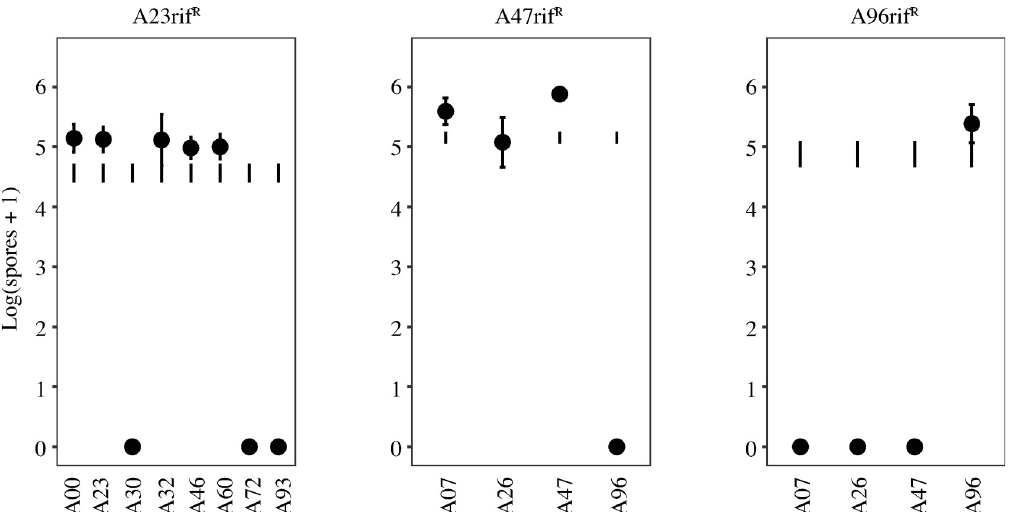
Fig 8. Antagonism patterns of focal minority strains in mixed groups during starvation-induced development. Actual spore production by marked natural isolates mixed in the minority at a 1:99 ratio with unmarked isolates (indicated on the x axis) prior to starvation-induced development is represented by closed circles. Expected spore production ranges of the minority strains based on pure-culture assays are depicted by error bars with no circles. Error bars represent 95% confidence intervals, n = 3 replicates.